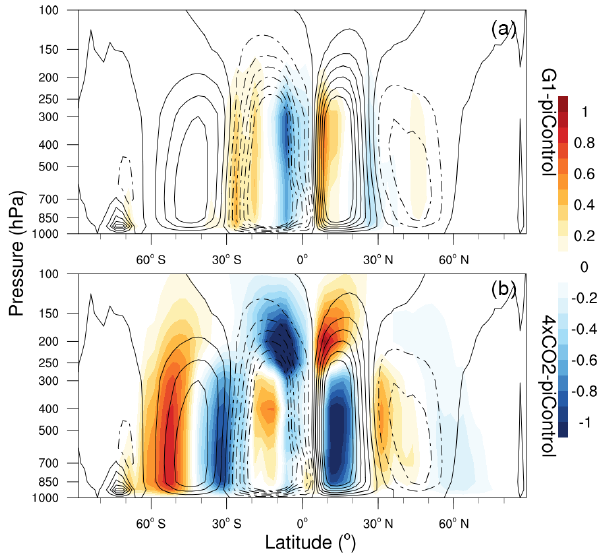
Figure 5. Shading indicates model ensemble mean zonal stream function anomalies (10 10 kgs − 1 ) G1-piControl (a) and abrupt4xCO2-piControl (b) . Warm colors (positive values) indi- cate a clockwise rotation and cold colors (negative values) indicate an anticlockwise rotation. Contours indicate the value of averaged meridional mass stream function (10 10 kgs − 1 ) in piControl as plot- ted in Fig.